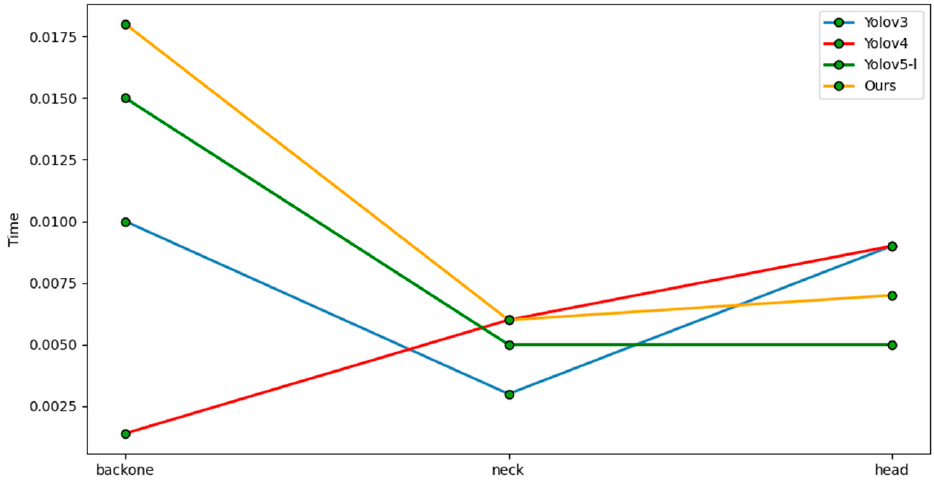
Figure 11. Time-consuming di ff erence diagram of di ff erent modules.